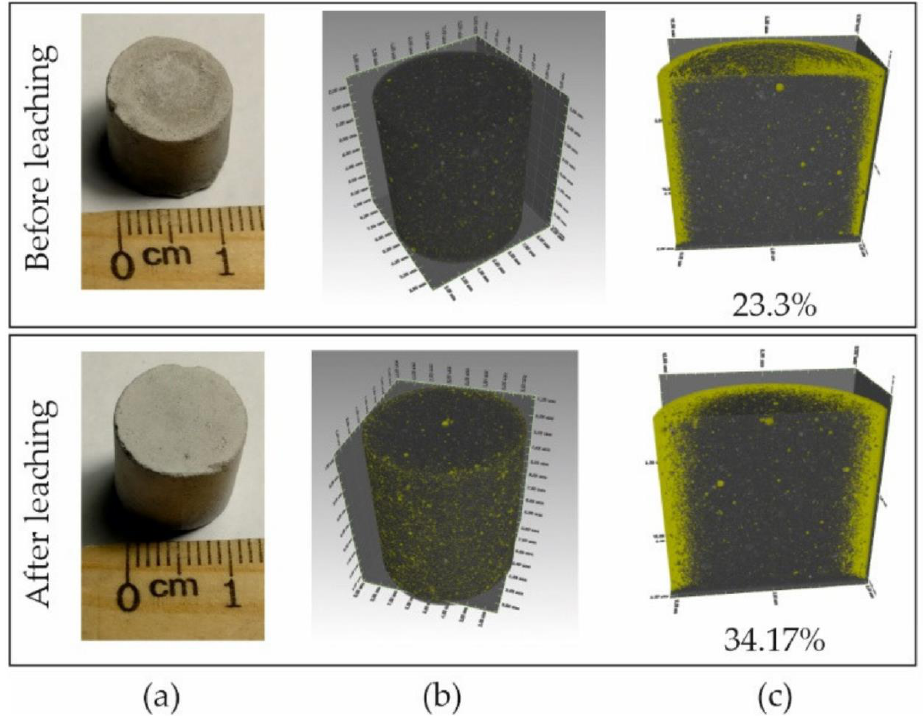
Figure 20. Illustration of the change in porosity of concrete sample as a result of interaction with the model solution. ( a )—photo of samples before and after the experiment; ( b )—3D model of samples, obtained with the help of µ -CT; ( c )—relative porosity, detected using µ -CT (% of volume) [66].